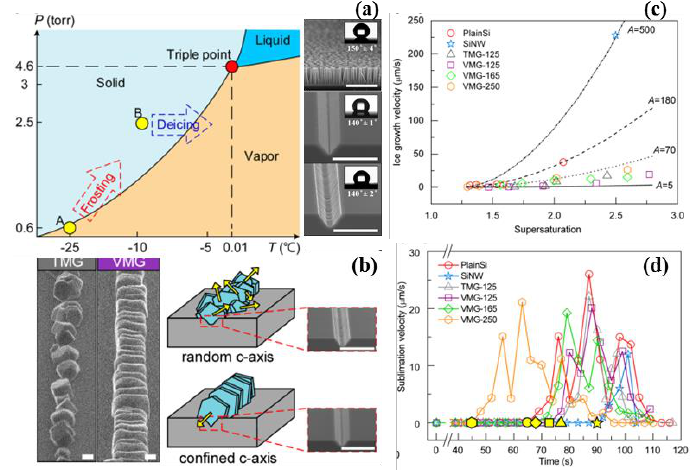
Figure 19. ( a ) Initial thermodynamic states of the frosting/de-icing processes and surface characterization; ( b ) Random and aligned orientations of c-axes on TMG and VMG surfaces, respectively; ( c ) Dynamics of the frosting processes under a high supersaturation condition; and ( d ) Dynamics of the de-icing processes. (Adapted from [174] with permission; Copyright 2017 ACS).